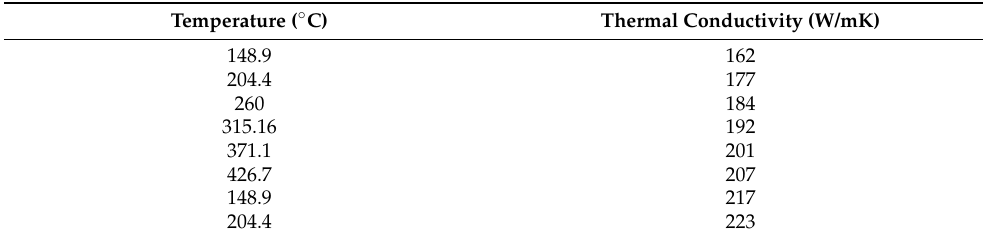
Table 3. AA6061-T6 thermal conductivity properties (temperature